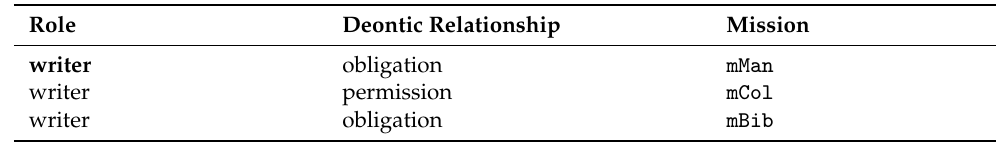
Table 6. Deontic specification for a simulation error example—obligation for an agent not eligible for the plan.